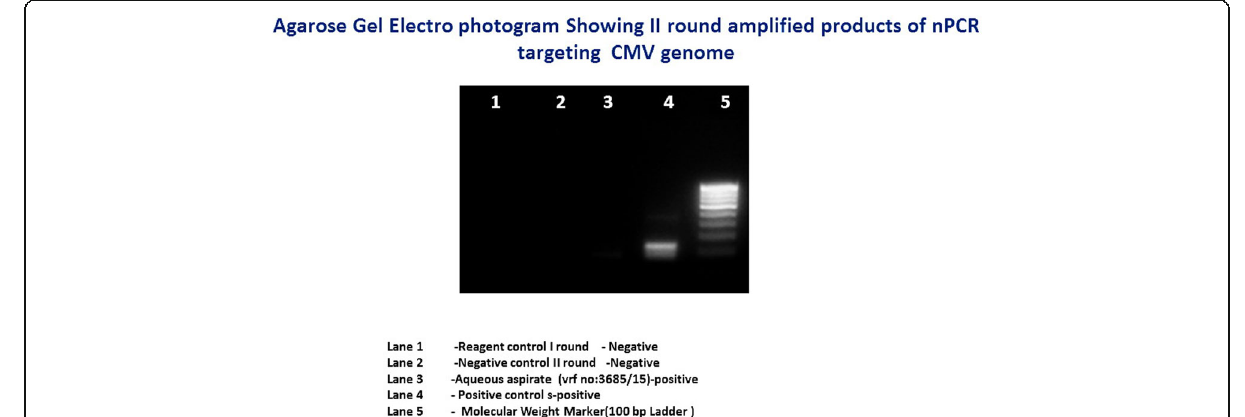
Fig. 4 Agarose gel electophotogram showing the detection of cytomegalovirus (CMV)